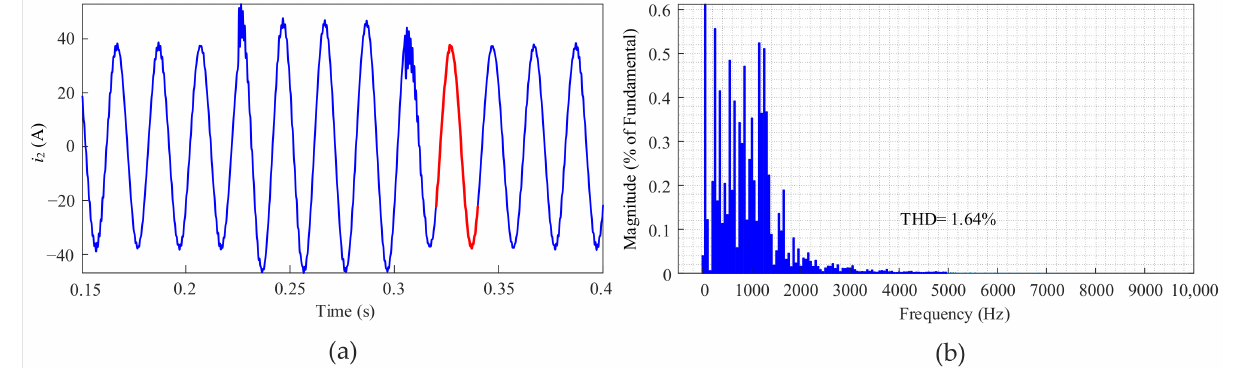
Figure 7. Simulation waveform of the grid-side current i L 2 and its FFT analysis result in Simulation 1 when L g = 0 and with the 5th, 7th, 11th, 13th order resonance controllers applied: ( a ) The simulation waveform; ( b ) the FFT analysis result.